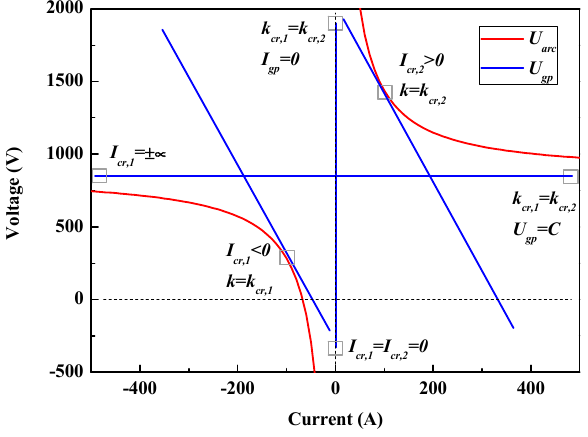
Figure 11. Possible real solutions of k cr and I cr for critical burning states in real plane.